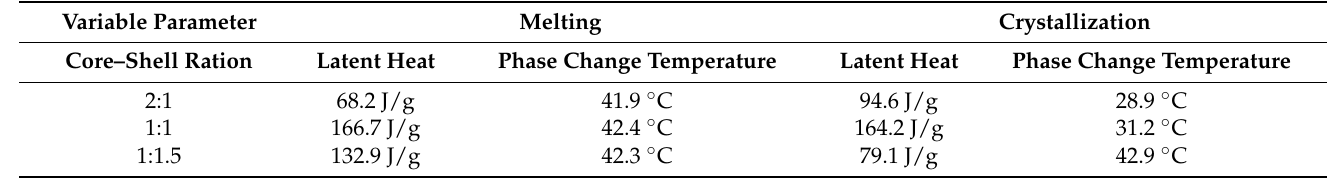
Table 9. Experimental results for changing the core–shell